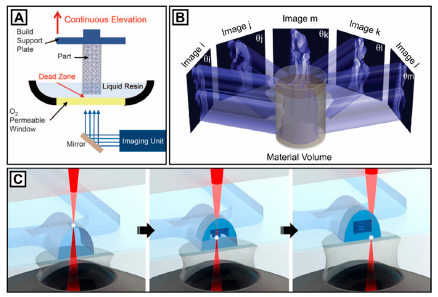
Figure 1. Recent innovations in additive manufacturing based on resin vats. ( A ) Schematic of continuous liquid interface production (CLIP) enabling continuous photopolymer processing at higher speed than conventional PµSL due to an oxygen inhibition layer at the bottom of the resin vat. Adapted with permission from Tumbleston et al. [37] ( B ) Computed axial lithography (CAL) system based on computed 3D exposure of a photoresponsive material from different angles. Adapted with permission from Kelly et al. [53] ( C ) Illustration of in situ direct laser writing ( is DLW). Focused femtosecond laser pulses, the spatially controlled photopolymerization, and the cured photomaterial are represented as red, white, and blue, respectively. Adapted with permission from Lamont et al.